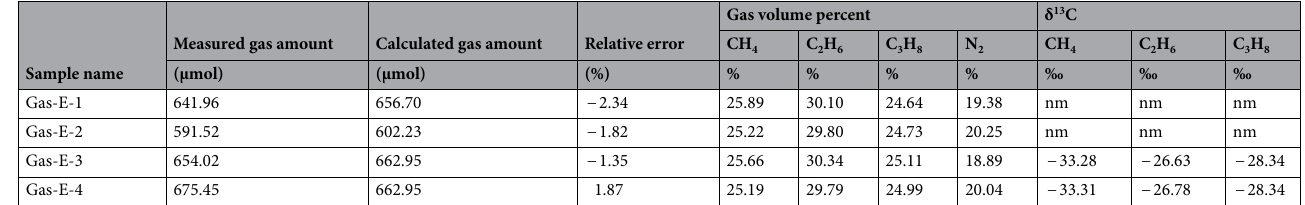
Table 1. The compositions and/or carbon isotope ratios of gaseous hydrocarbons collected from four small gold tubes. nm not